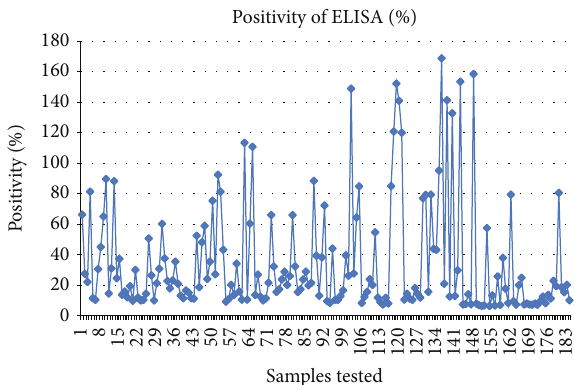
Figure 3: Percent positive plot of samples tested for anti- A. marginale antibody by indirect ELISA.